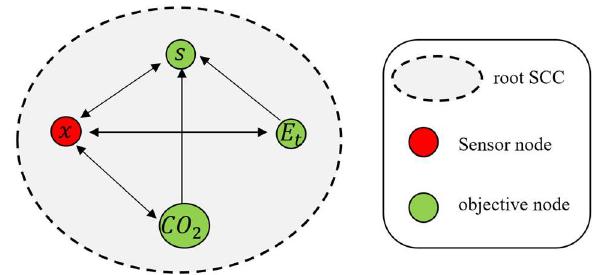
Figure 5. Observability analysis (inference diagram) of Equation (5).